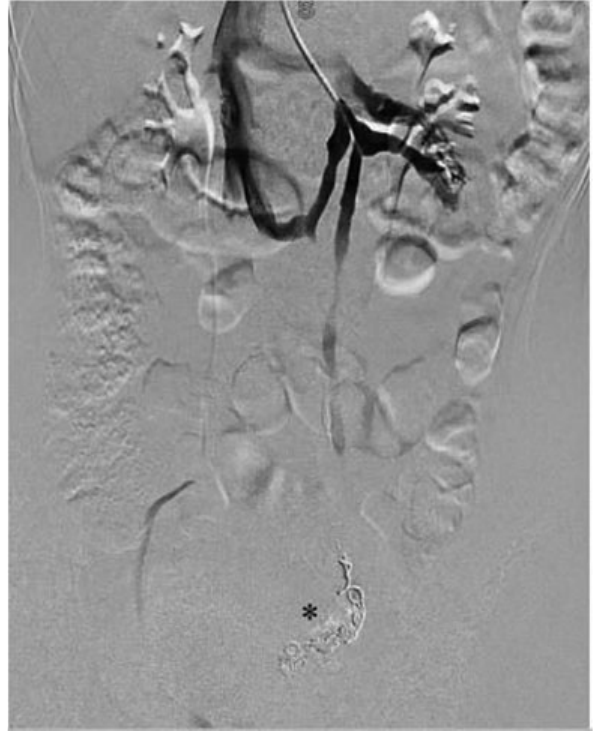
Fig. 4 Venography image showing the circumaortic left renal vein and the Hydrocoils (black star) used for the parauterine and left ovarian veins embolization.